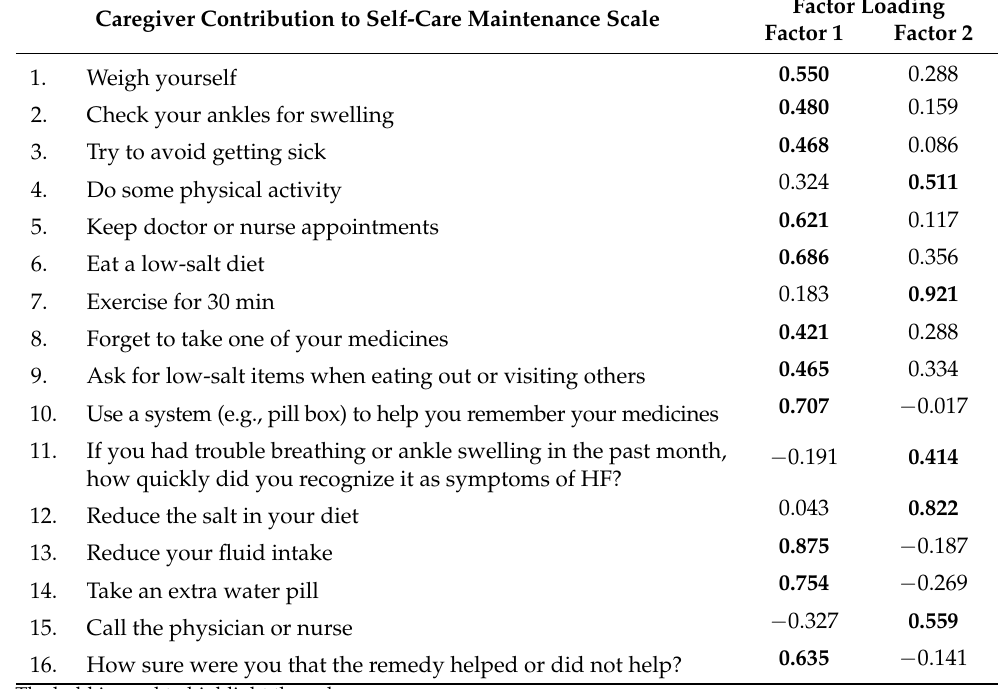
Table 4. Factor pattern of the Caregiver Contribution to Self-Care of Heart Failure Index (CC-SCHFI). Caregiver Contribution to Self-Care Maintenance